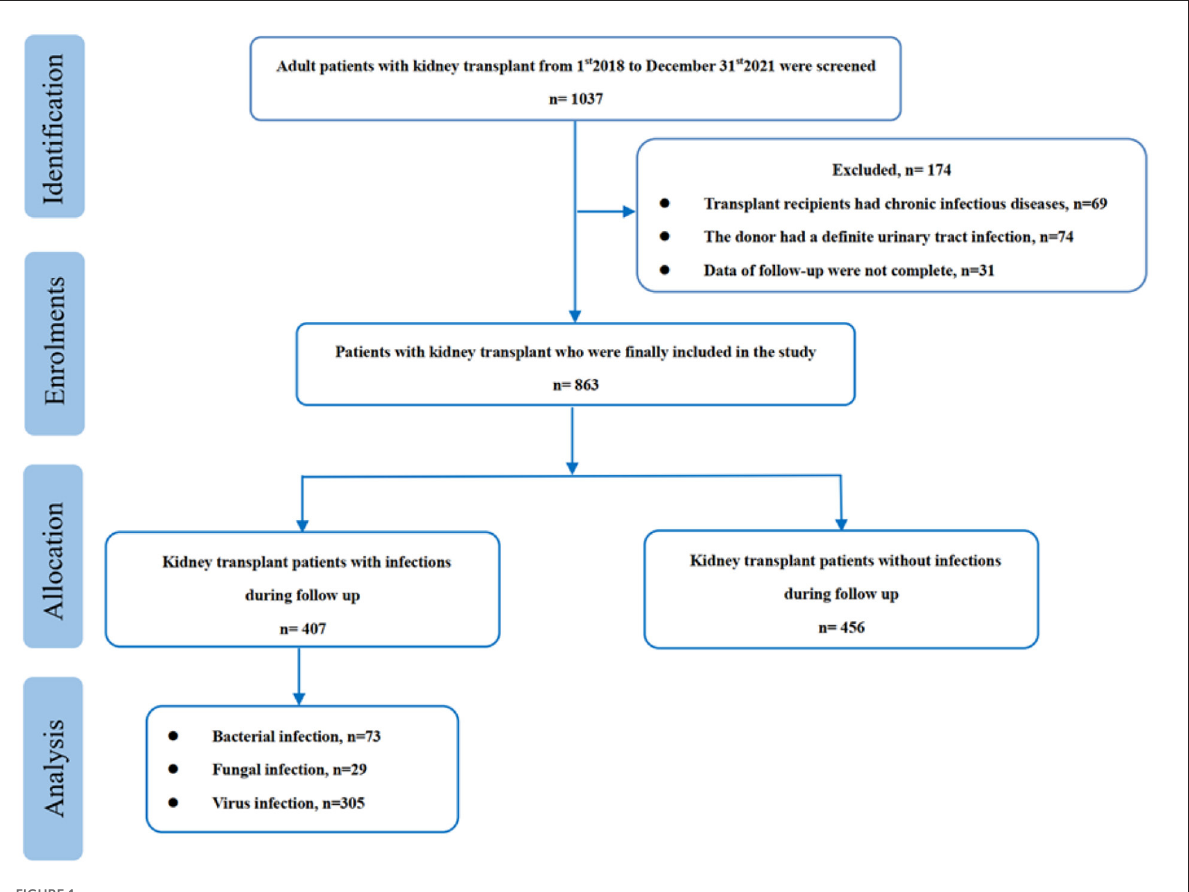
FIGURE1 Flow chart of the